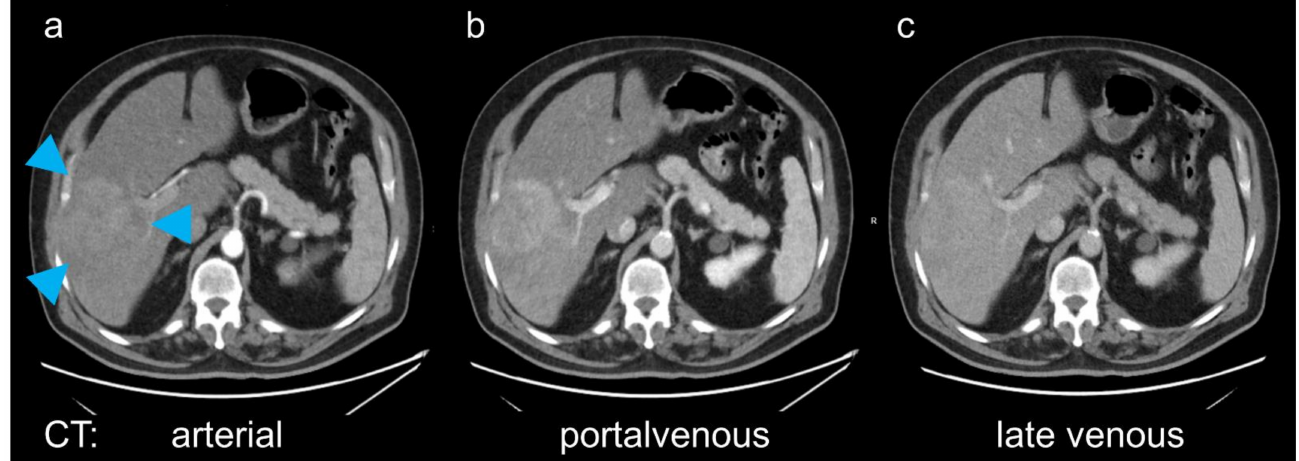
Figure 1. In the presented patient, on computed tomography (CT) the mass in the right liver lobe (a, arrowheads) showed arterial ( a ) and portalvenous ( b ) enhancement, with a mixed appearance on the late venous phase with slightly hyper-, but also hypodense areas ( c ). The diagnostic dilemma was that a biopsy should be avoided, and the patient could not undergo magnetical resonance (MR) imaging because of a pacemaker. Fast dynamic hepatobiliary scintigraphy is limited to planar acquisition, and not feasible for the evaluation of focal lesions [2].